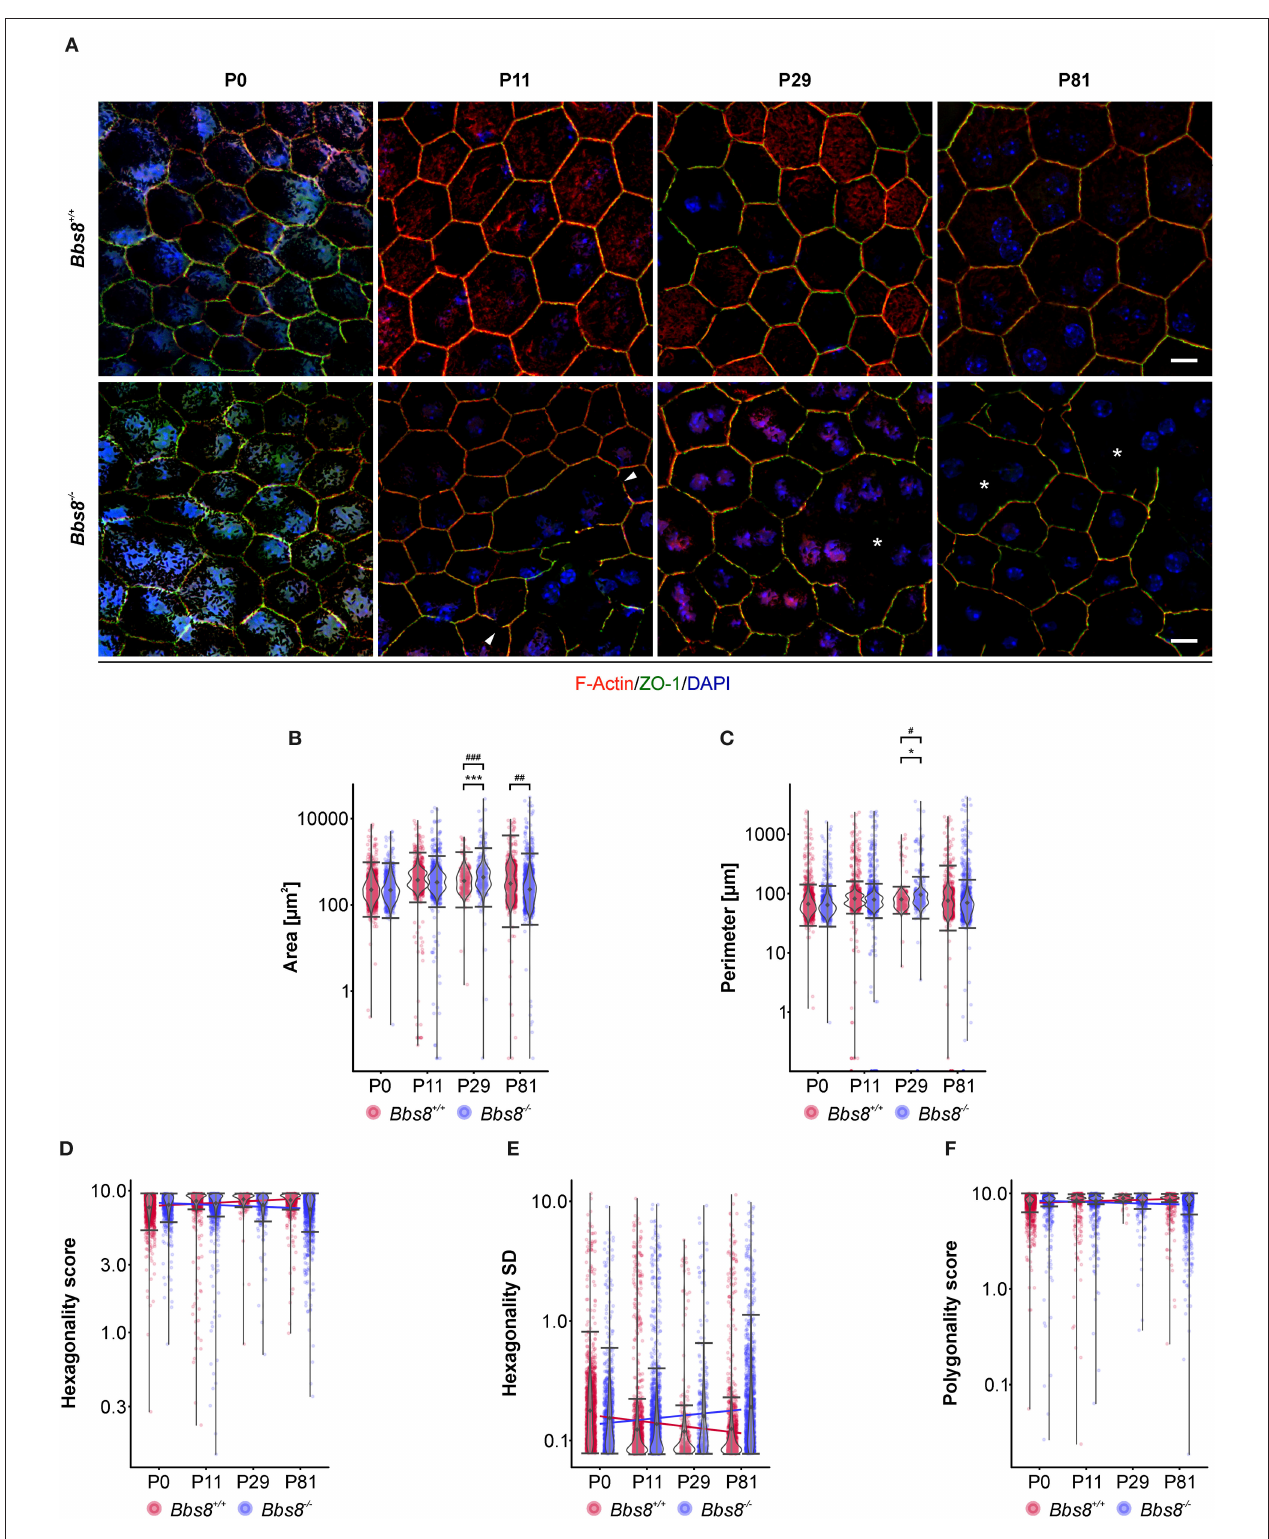
FIGURE 6 | Cell morphological defects are seen in Bbs8 -deficient RPE. (A) Representative images of RPE flatmounts stained for F-actin (red) and ZO-1 (green) to visualize cytoskeleton and cell membrane. DAPI was used to stain nuclear DNA. P11 Bbs8 − / − RPE shows discontinuous membrane staining (arrowheads). Starting